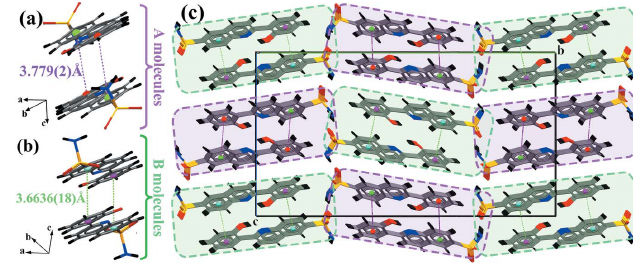
Figure 4 (cid:2) – (cid:2) stacking interactions in (I), showing ( a ) the resulting stacks formed by the A molecules; ( b ) a similar view showing the stacks formed by the B molecules and ( c ) a view along the a axis of the stacked A and B molecules. Dashed magenta lines denote Cg 2 (cid:3)(cid:3)(cid:3) Cg 3 contacts and dashed light-green lines Cg 6 (cid:3)(cid:3)(cid:3) Cg 7 contacts.